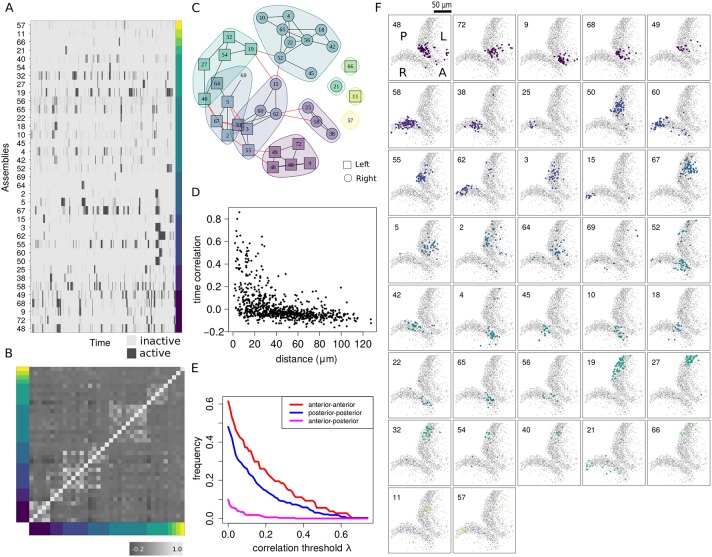
Networks of assemblies in the zebrafish tectum.(A) Raster plot of assembly activity ordered according to subnetwork membership as shown in C. (B) Raster plot of the time correlation matrix (Pearson’s) between all pairs of assemblies averaged across posterior samples and sorted according to subnetwork membership. (C) Subnetwork graphs representing the time correlations among neuronal assemblies (see Materials and methods). Each assembly is a node, shorter edges reflect higher temporal correlations. Note the absence of edges between assemblies located in ipsilateral anterior and posterior tectum (see S3 Video). (D) Scatter plot showing the relationship between time correlation and physical distance between neuronal assembly centers (1pixel ≈ 0.9μm). (E) Fraction of assembly pairs with correlation larger than λ as a function of λ. Ipsilateral pairs of assemblies located at opposite sides in the anterior-posterior axis display a significant reduction in correlation compared to neighboring assembly pairs (anterior-anterior and posterior-posterior). (F) Locations of all assemblies from a single larva (see S2 Video for the assembly distributions in 3D). Each assembly is color-coded according to subnetwork memberships shown in C.